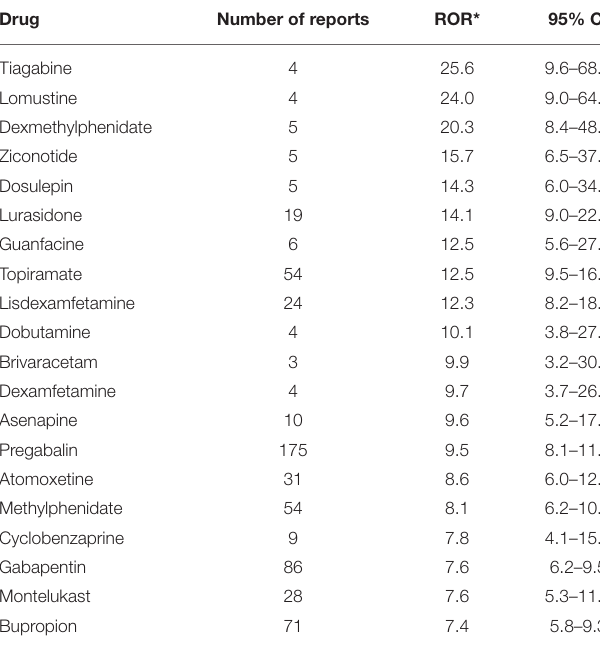
TABLE 1 | Top 20 drug-stuttering associations at the fifth ATC level ranked according to the highest disproportionality (ROR value) in VigiBase. Drug Number of reports